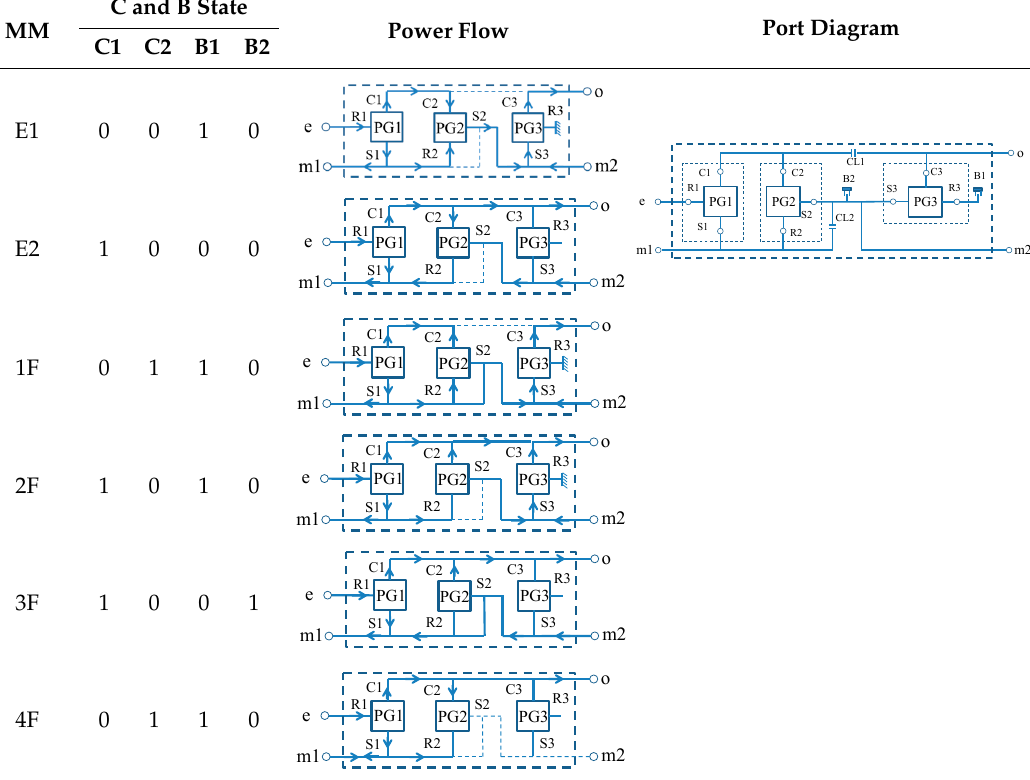
Table 5. The power flow of the main drive modes of GM AHS2 by four-port diagram.